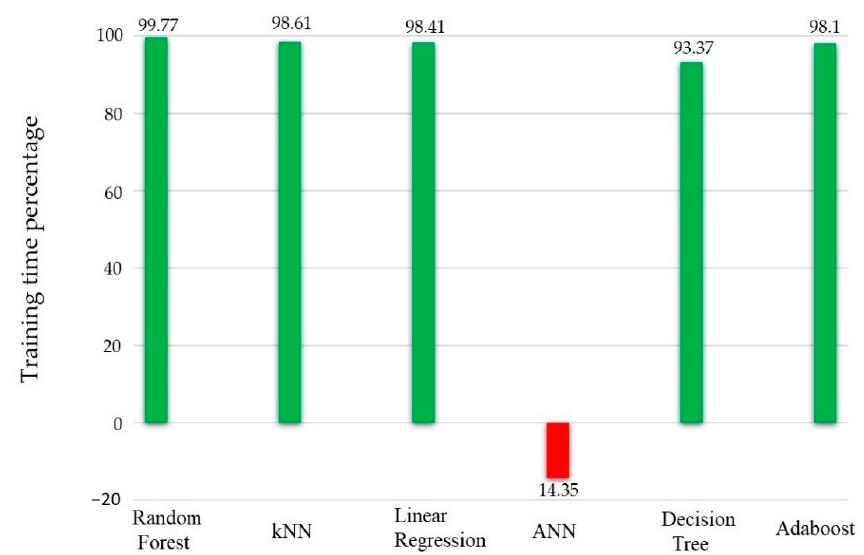
Figure 11. Comparison of the predictive algorithms training times required on a percentage basis using the hybrid model (modified data set).